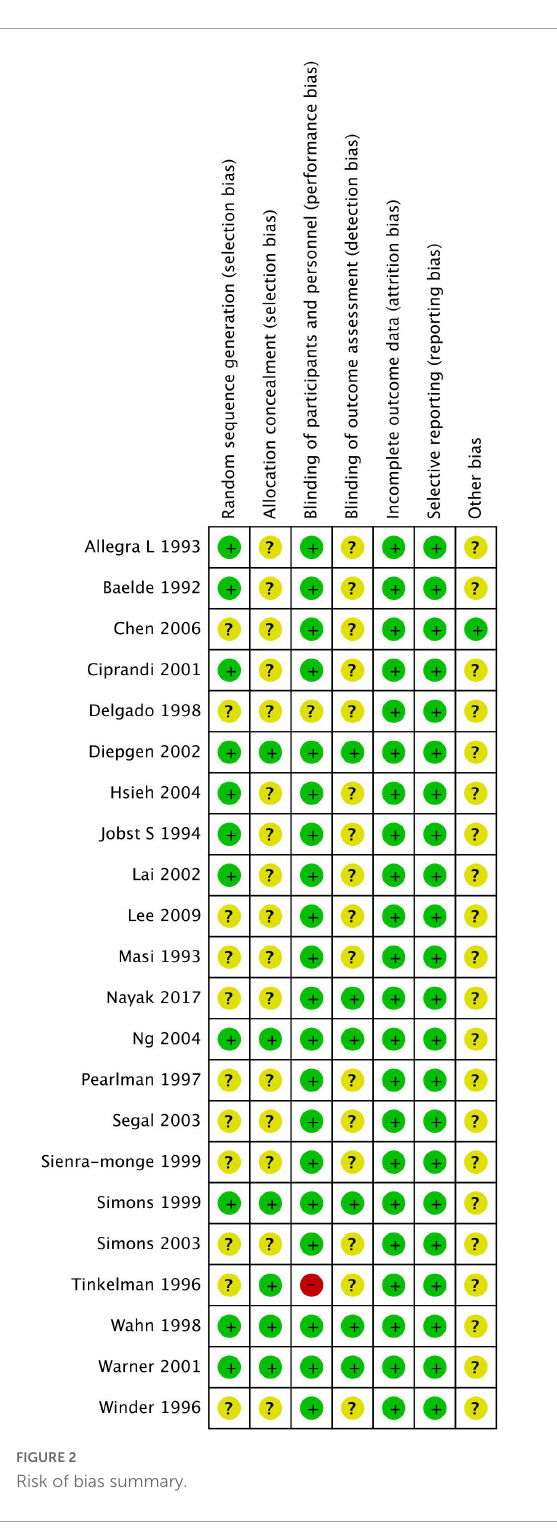
FIGURE2 Risk of bias